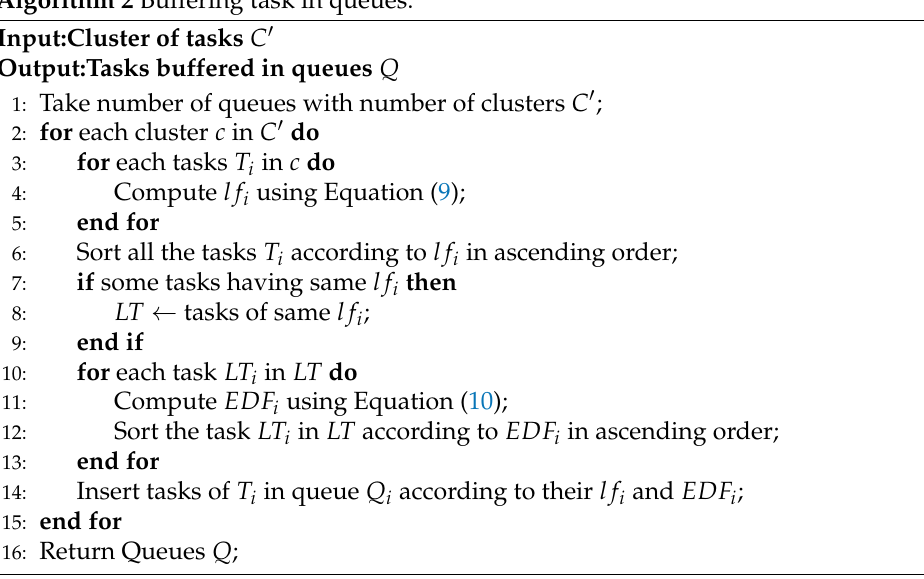
Algorithm 2 Buffering task in